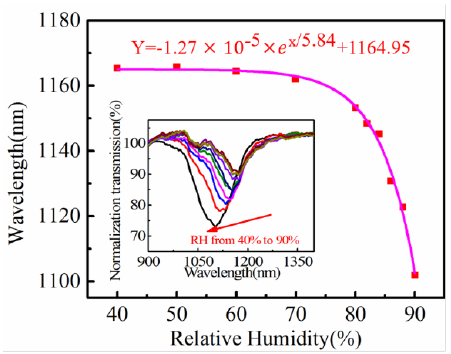
Figure 5. Monotonic shift of the resonance towards shorter wavelengths with RH increasing for a fiber SPR sensor with an initial wavelength of 1165.29 nm. Table 1. The sensitivity and dynamic range of different configurations.